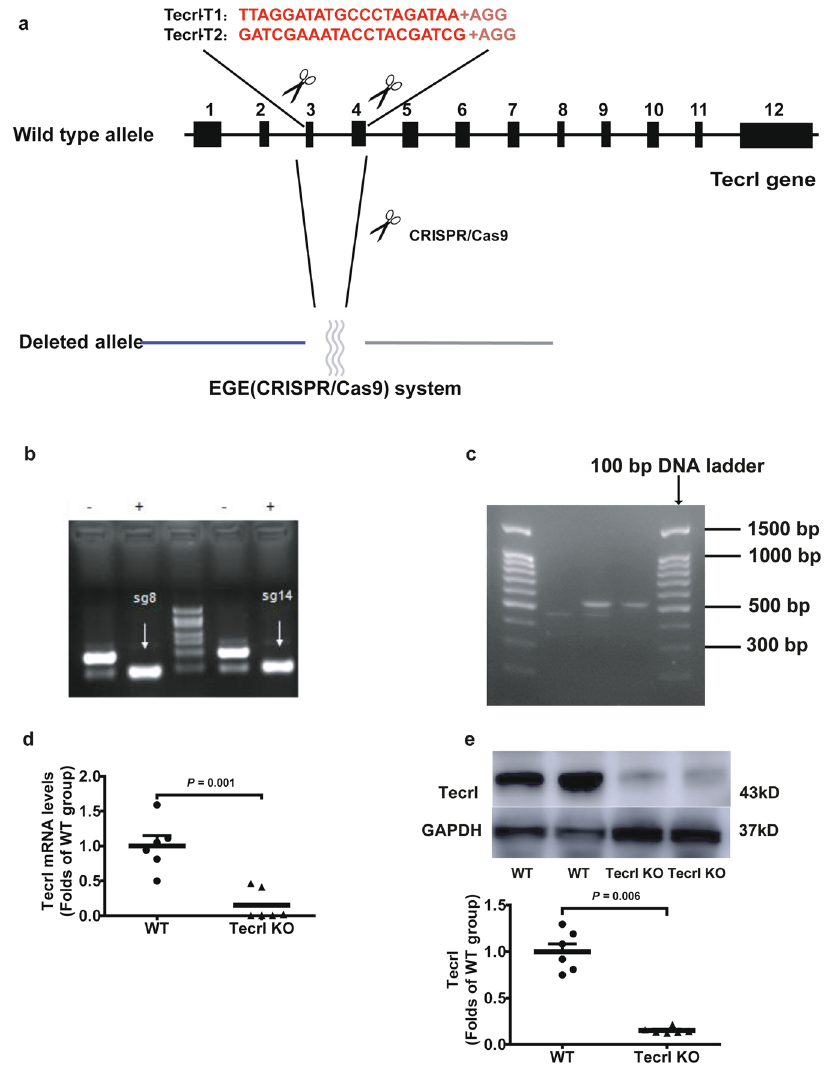
Fig. 1 Generation of Tecrl KO mice using CRISPR/Cas9. a The general structure of Tecrl gene. Two sgRNA sequences and a schematic diagram of two sgRNA target sites located in exon 3 and exon 4 of the mice Tecrl locus. Target sites of two sgRNA sequences (Tecrl-T1 and Tecrl-T2) are highlighted in red. b Representative of sgRNA images. c Representative of the PCR images. Only one band at position 537 represented the Tecrl KO mice, one band at position 455 represented the WT mice, while one at position 537 and one at position 455 represented the heterozygote mice. d Quanti fi cation of the Tecrl mRNA level in the WT and Tecrl KO mice. e Representative of the immunoblotting images and quanti fi cation of the expression of Tecrl in the WT and Tecrl KO mice. The DNA ladder (DL2000). Values are means± SE. P < 0.05 was considered signi fi